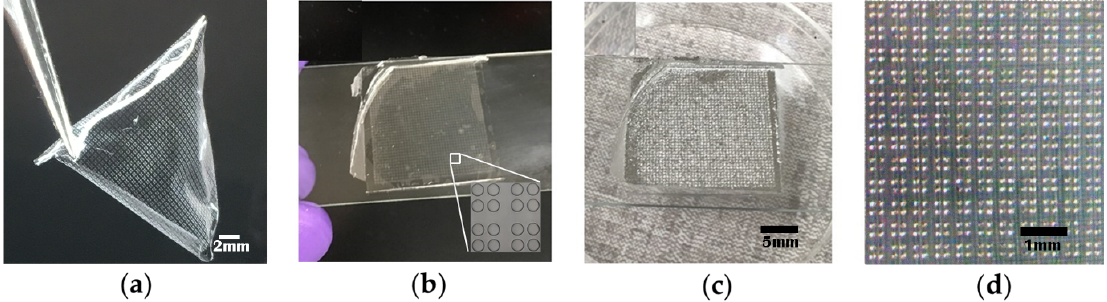
Figure 7. ( a ) UV-curable polymeric membrane (2 cm × 2 cm) and ( b ) the membrane attached to a glass substrate. ( c ) Galinstan was sprayed on the polymer membrane and ( d ) the LM dots pattern remained on the glass substrate after peeling off the membrane.